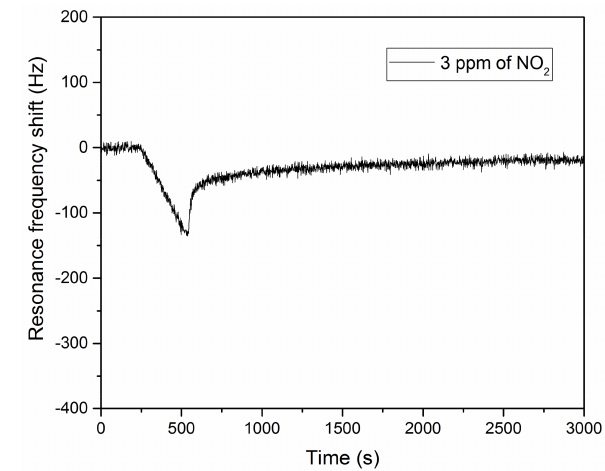
Figure 7. Resonance frequency shift of a Cu(OH) 2 nanostructured piezoresistive cantilever exposed to 3 ppm of NO 2 in non-condensation conditions (cantilever 55 ◦ C, NO 2 source 23 ◦ C). All the experiment (stabilization, detection and post detection phases) were done with an air flow saturated with water. After five minutes of stabilization, the cantilever was in contact with NO 2 over 5 min.